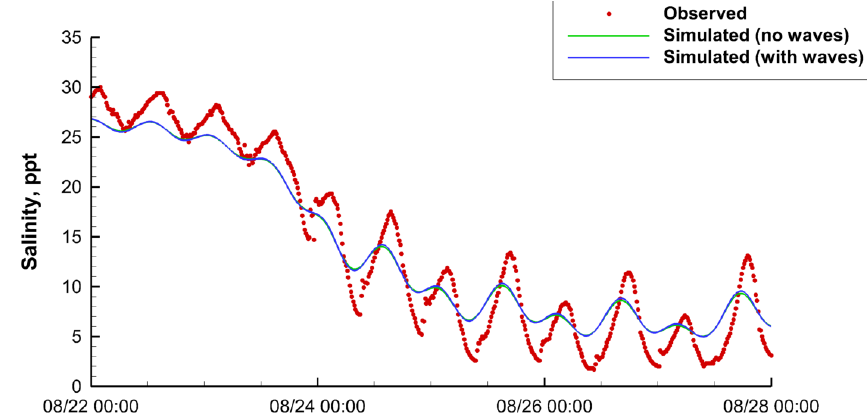
Figure 20. A comparison between simulated (hindcast) and observed salinity at the Pine Island Station (EC domain) during Tropical Cyclone Fay (2008).